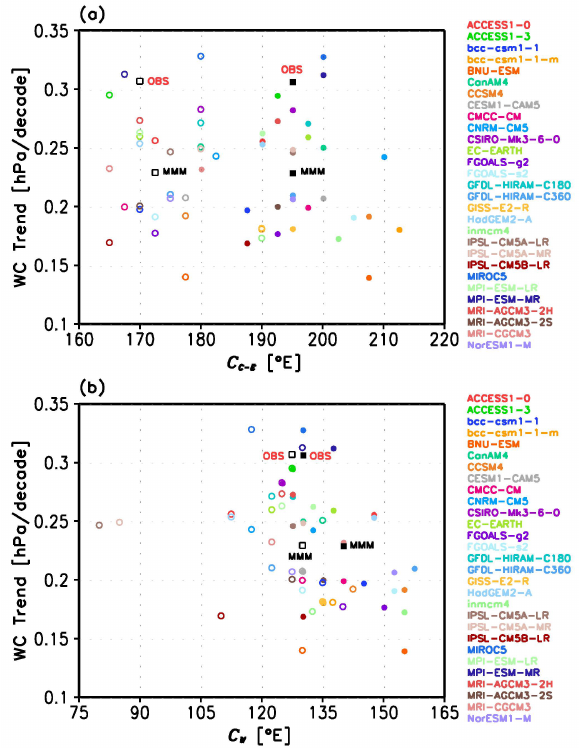
Figure 4. Same as Figure 3a,b, but during El Niño (closed marks) and La Niña (open